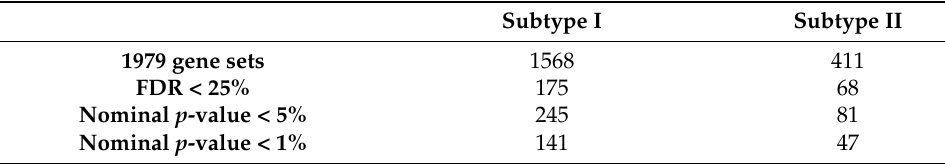
Figure 6. Pathways enriched in epithelioid malignant plural mesothelioma subtypes. ( A ) Subtype I KEGG pathways of eMPM. ( B ) KEGG pathways in subtype II eMPM. Table 1. Number of overexpressed and down-expressed genes set in